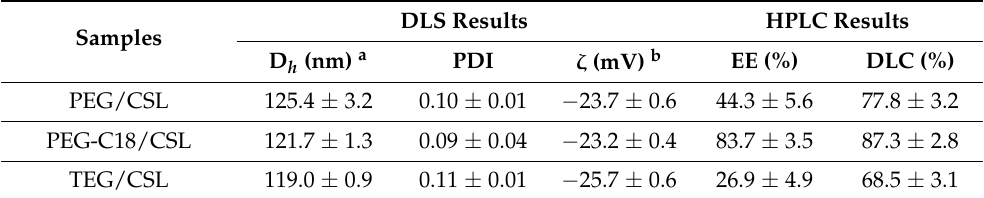
Table 1. Results of three CSL-loaded nanoparticles. Samples